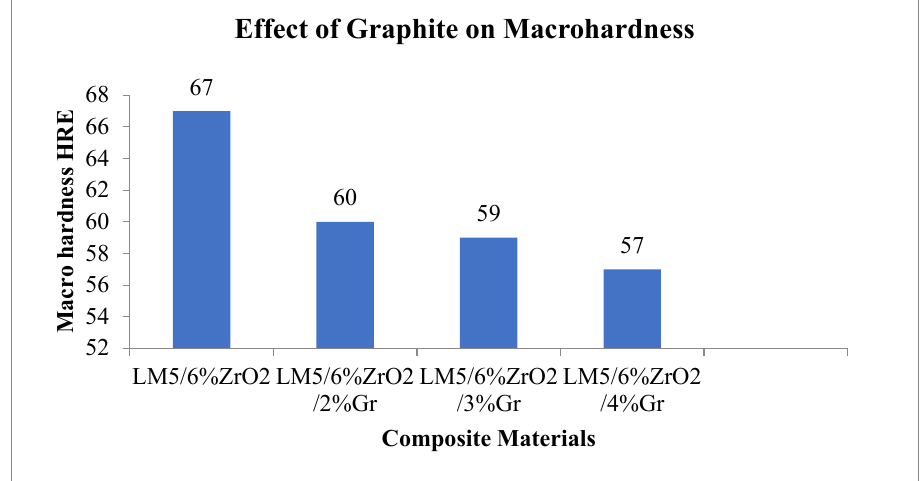
Figure 11. Effect of graphite on the macrohardness of composites.